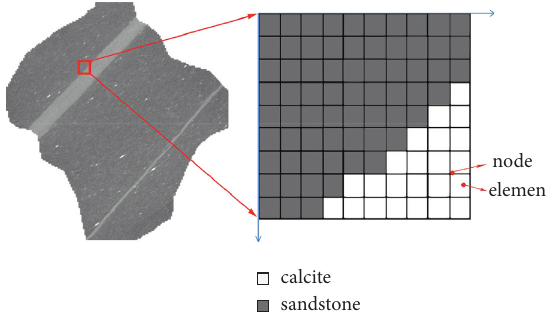
Figure 5: Finite element conversion process of sandstone particle digital image. Table 1: Material parameters of a rock sample.